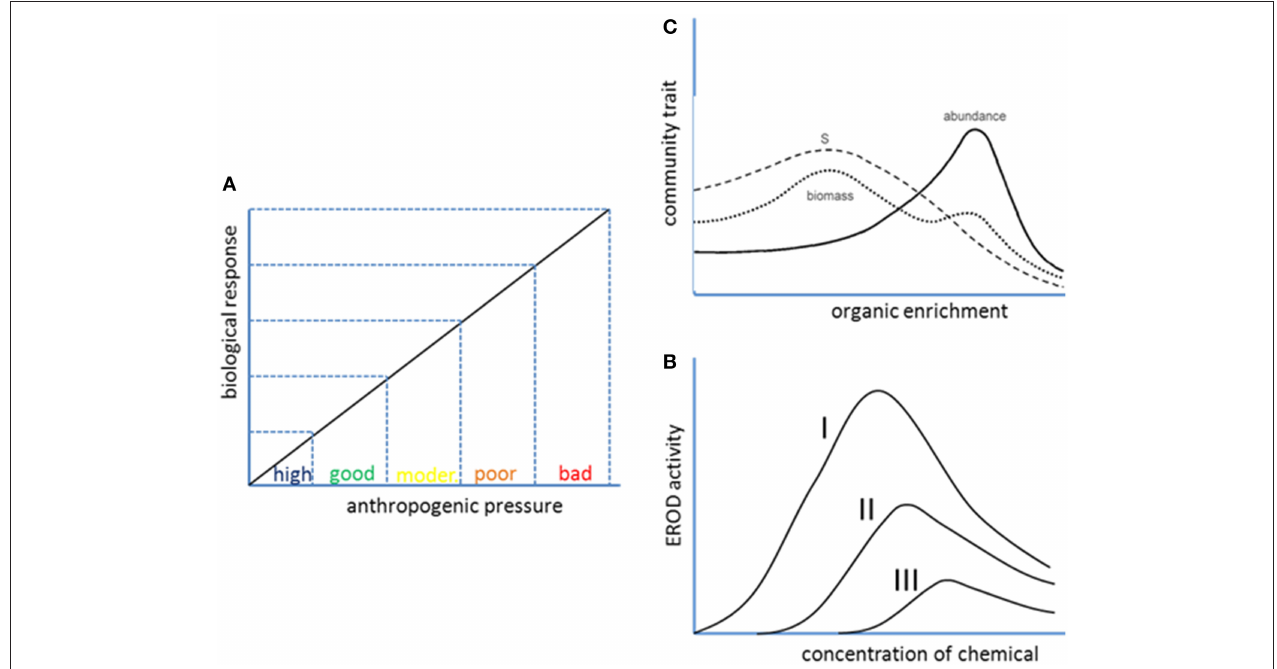
FIGURE 2 | Quantitative patterns of biological response to anthropogenic pressures. A linear or linearizable response (A) is assumed in the current scheme of use of ratio-to-reference values for classification of ecological status of water bodies into one of five categories (high, good, moderate, poor, or bad). However, bell-shaped responses are frequent at different levels of biological organization, from molecular biomarkers to community indices. (B) Shows EROD activity vs. concentration of three chemicals of decreasing potency from Petrulis and Bunce (1999). (C) Shows the well-known Pearson and Rosenberg (1978) paradigm according to which species richness in benthic communities is maximum at intermediate levels of organic